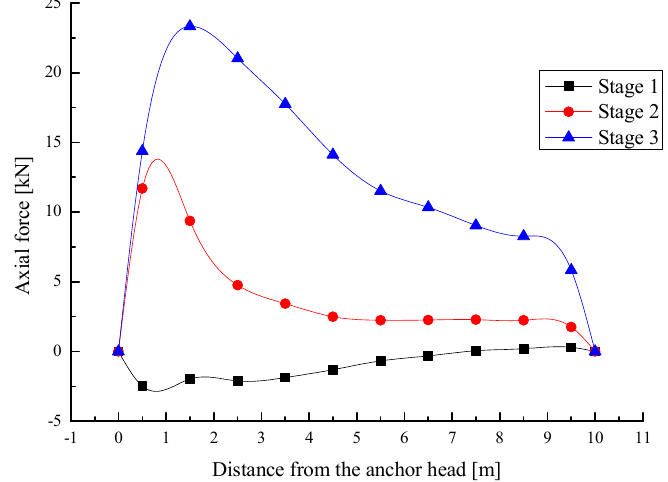
Figure 13. Axial forces of anchor #2 at different stages.